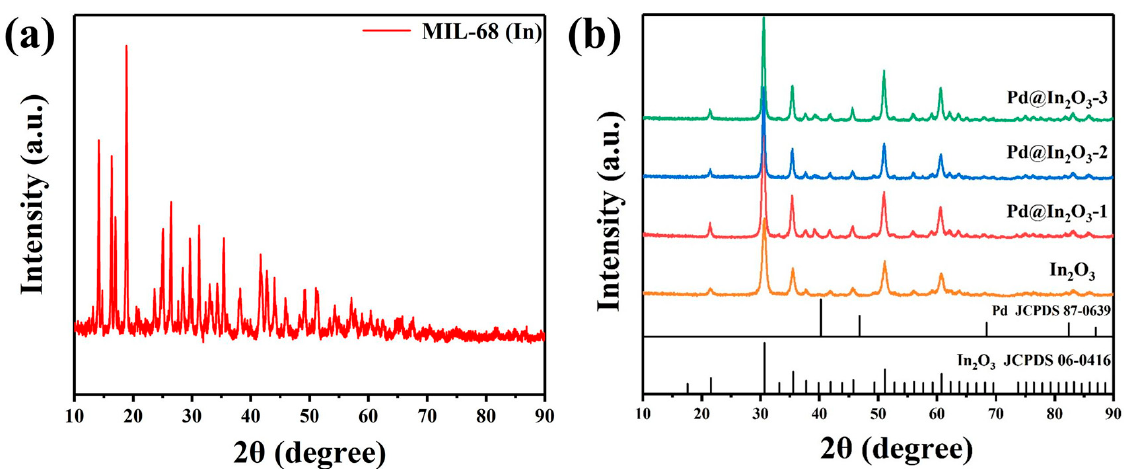
Figure 3. XRD patterns of ( a ) MIL-68 (In) and ( b ) pristine In 2 O 3 , Pd@In 2 O 3 -1, Pd@In 2 O 3 -2 and Pd@In 2 O 3 -3.